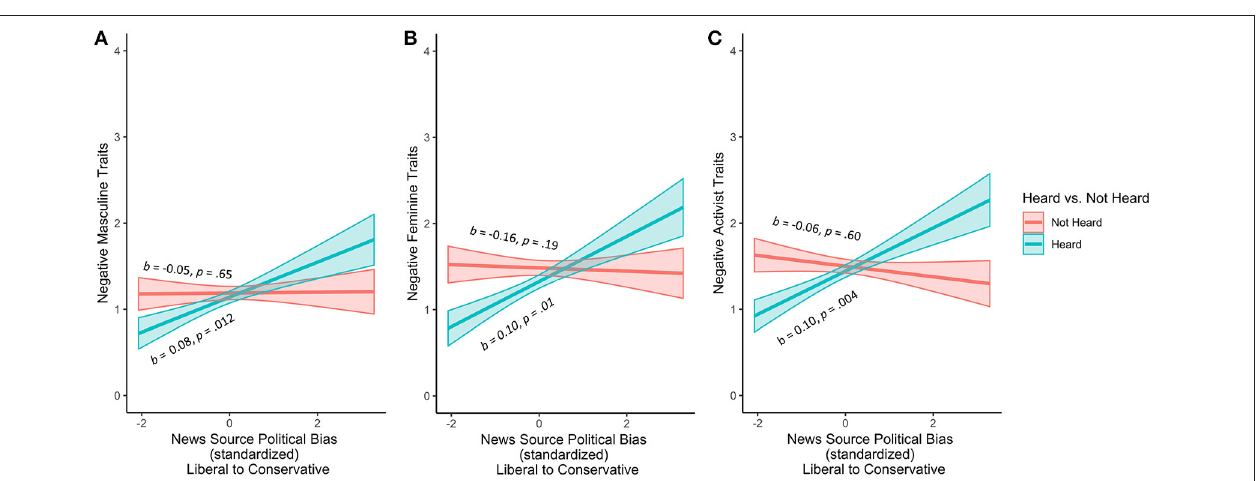
FIGURE 4 | Impressions of marchers as a function of whether heard x news source. (A) F (1, 272) = 3.80, p = 0.052, 95% CI[0.01, 0.10], PRE = 0.02; Scale bands represent 95% confidence intervals. (B) F (1, 272) = 6.05, p = 0.014, 95% CI[0.01, 0.10], PRE = 0.02; Scale bands represent 95% confidence intervals. (C) F (1, 272) = 8.94, p = 0.003, 95% CI[0.02, 0.10], PRE = 0.03; Scale bands represent 95% confidence